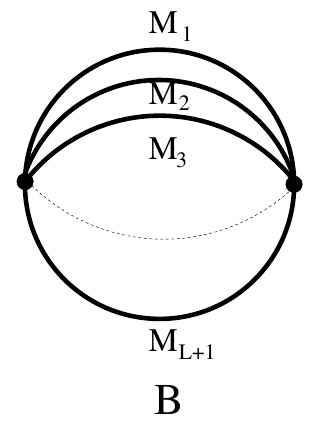
Figure 2 . L -loop bubble